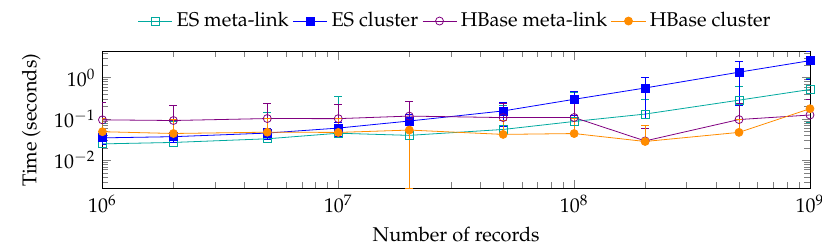
Figure 12. Prepared data fetching and on-demand computing execution times for identical